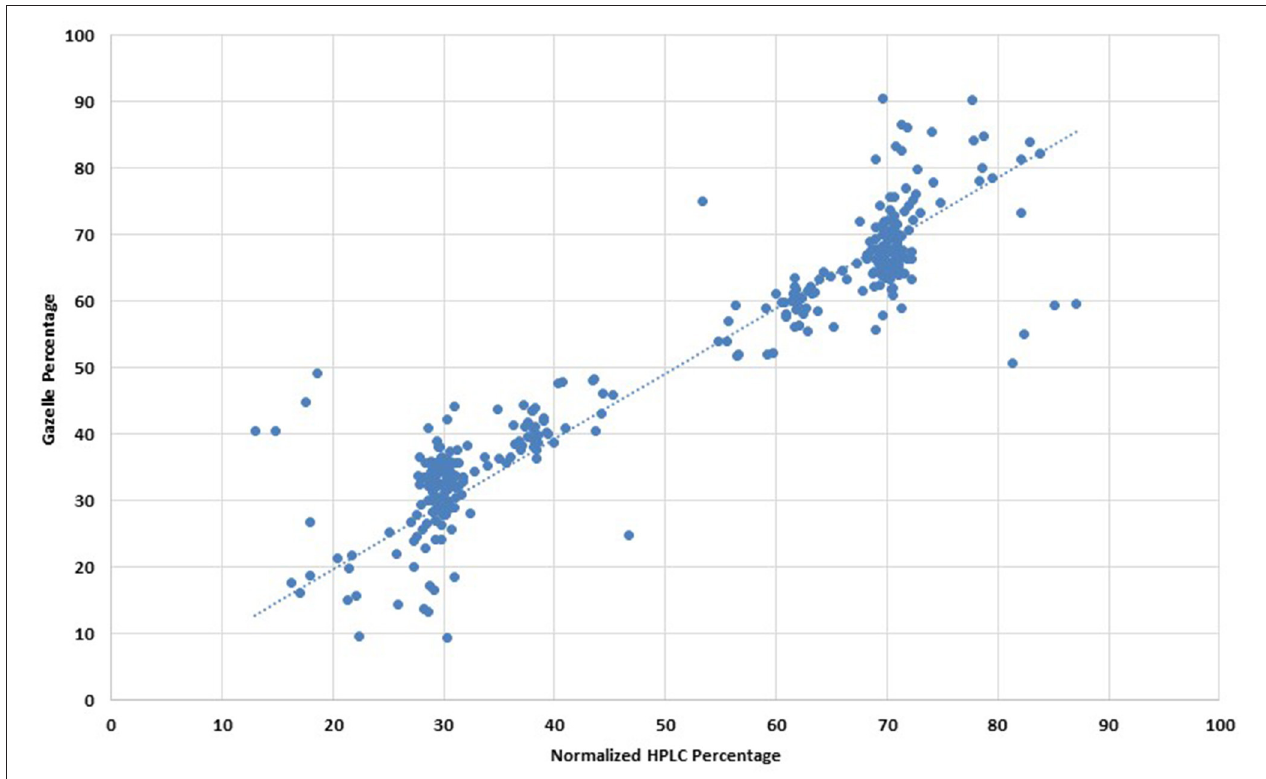
FIGURE 4 | Comparison of hemoglobin quantification percentages between normalized HPLC and Gazelle. *Note: This is applicable to all Hb types, not only HbS. Graphic representation of Pearson Correlation Coffeficient